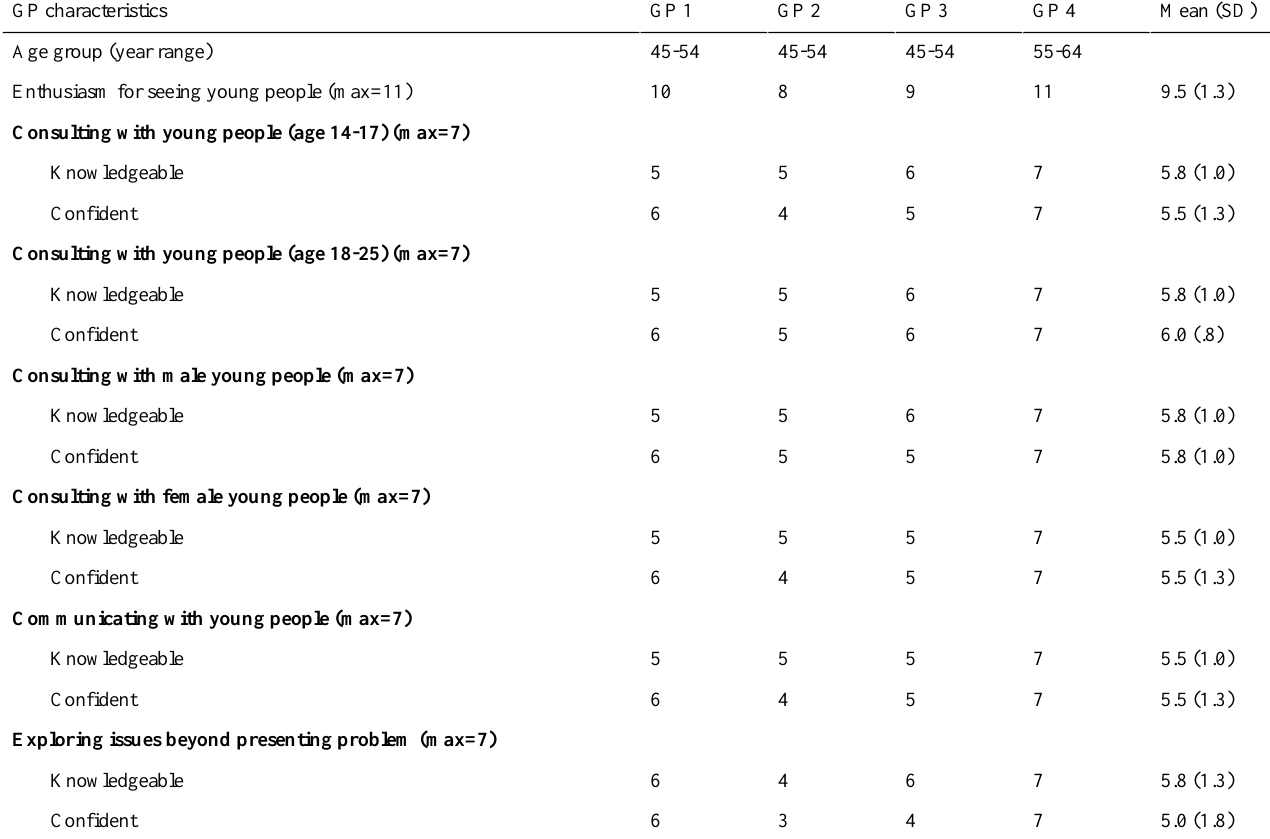
Table 3. General practitioner (GP) self-rated enthusiasm, and knowledge and confidence of consulting and communicating with young